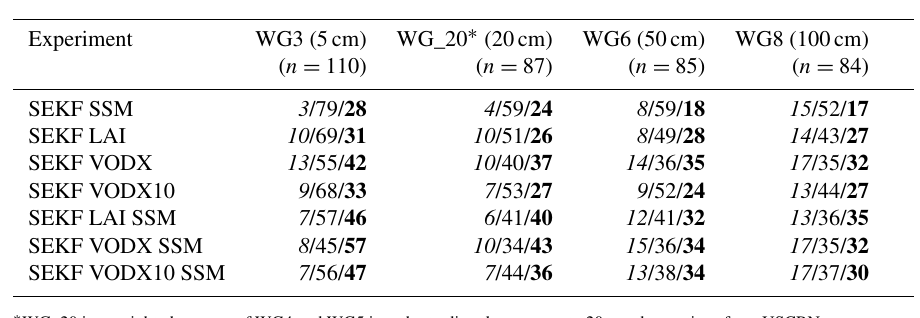
Table 4. Number of degraded (italics)/neutral/improved (bold) USCRN stations after assimilation using NIC r between the OL and various LDAS-Monde experiments at 5, 20, 50, and 100cm depths. Stations are considered improved if the NIC r is greater than 3, degraded if the score is less than 3, and neutral if it is between − 3 and 3.